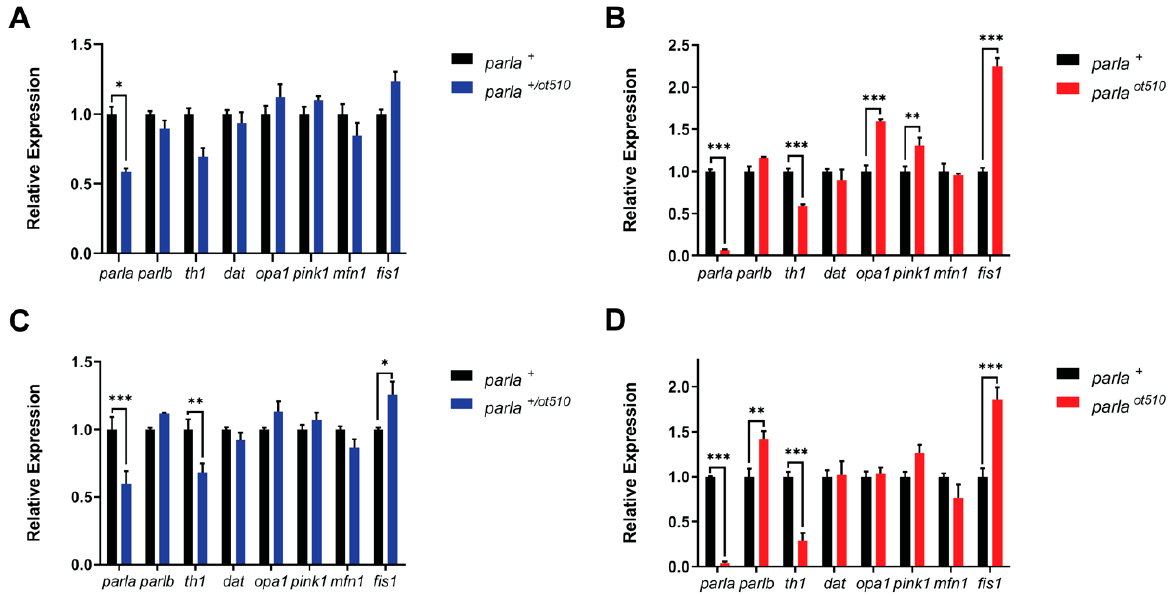
Figure 2. Effect of parla loss-of-function on the expression of genes associated with dopaminergic- and mitochondrial function in larvae and in the adult zebrafish brain. ( A , B ) Relative expression of parla , parlb , th1 , dat , opa1 , pink1 , mfn1 , and fis1 of 5 dpf zebrafish larvae ( n = 3. Each replicate contains 7 homogenized whole larvae). ( C , D ) Relative expression of parla , parlb , th1 , dat , opa1 , pink1 , mfn1 , and fis1 of 4–10 mpf adult zebrafish brains ( n = 3). WT fish are represented by parla + , homozygous mutants by parla ot510 , and heterozygous mutants by parla +/ot510 . Bars represent the Mean ± the SEM. * ( p < 0.05), ** ( p < 0.01), *** ( p < 0.001).